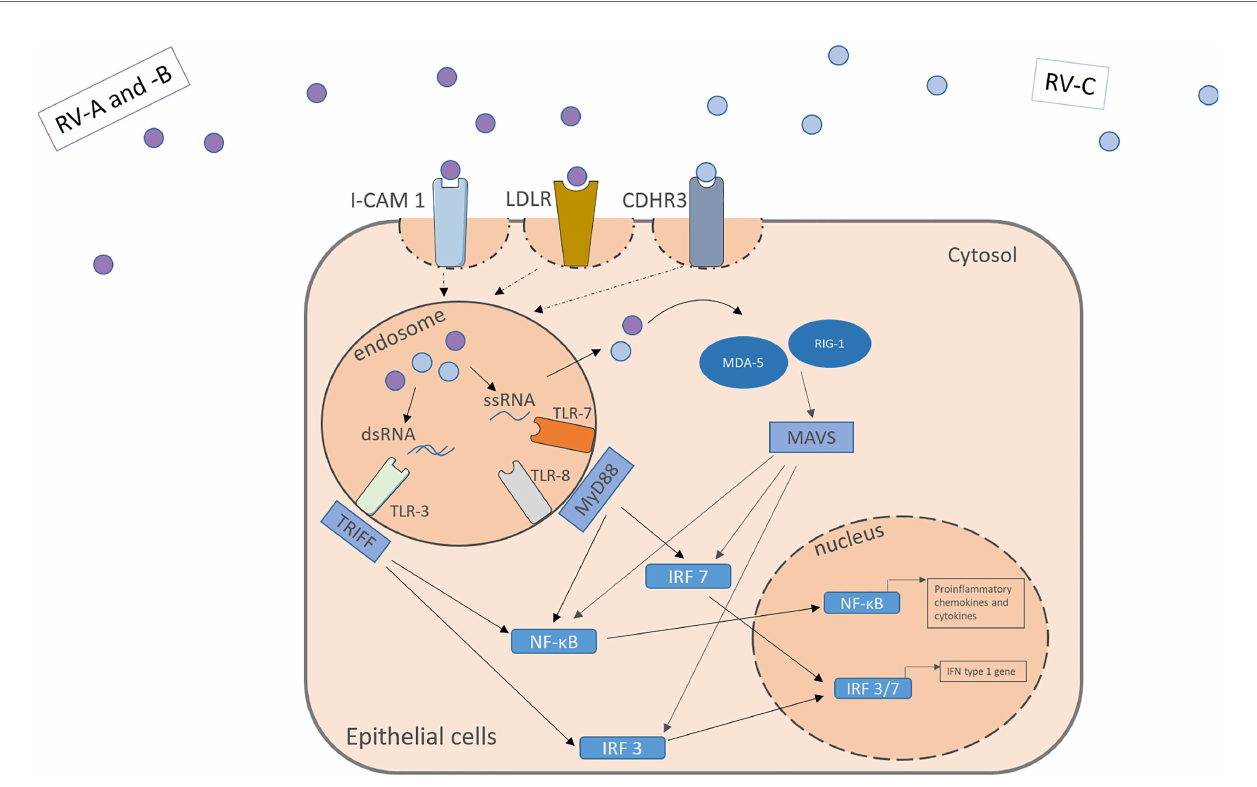
FIGURE 1 | RV activates receptors located apically on the target cell surface. RV-A and – B from the major and minor group activate the ICAM-1 or LDLR, respectively. RV-C enter the cells through CDHR3. Within the cells the virus genome activates pattern recognition receptors in the endosome and the cytosol including TLR3, TLR7, TLR8, MDA-5 and RIG-I leading to the downstream signaling and the translocation of transcription factors into the nucleus. NF- k B and IRF 3/ 7 bind to speci fi c genes enhances the transcription of proin fl ammatory cytokines, chemokines and IFN type I genes. IFN, interferon; RV, Rhinovirus; ICAM-1, Intercellular Adhesion Molecule 1; LDLR, Low-Density-Lipoprotein-Receptor; CDHR3, Cadherin Related Family Member 3; dsRNA, double stranded RNA; ssRNA, single stranded RNA; TLR, toll-like-receptor; TRIFF, TIR-domain-containing adapter-inducing interferon- b ; MyD88, Myeloid differentiation primary response 88; NF- k B, nuclear factor ‘ kappa-light-chain-enhancer ’ of activated B-cells; IRF, Interferon regulatory factor; MDA-5, melanoma differentiation-associated protein 5; RIG-1, retinoic acid inducible gene I; MAVS, Mitochondrial antiviral-signaling